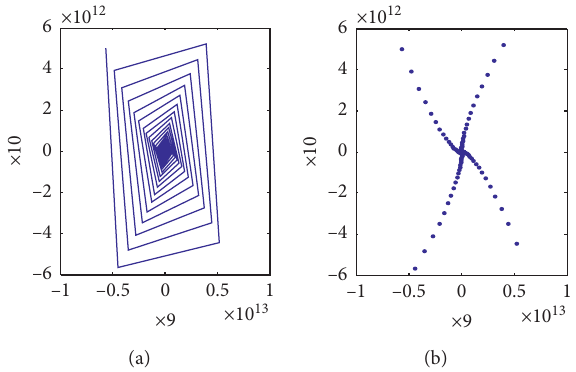
Figure 12: ω � 265 without random perturbation. (a) Phase trajectories. (b) Poincare maps. –1–0.500.511.522.5 10 ×